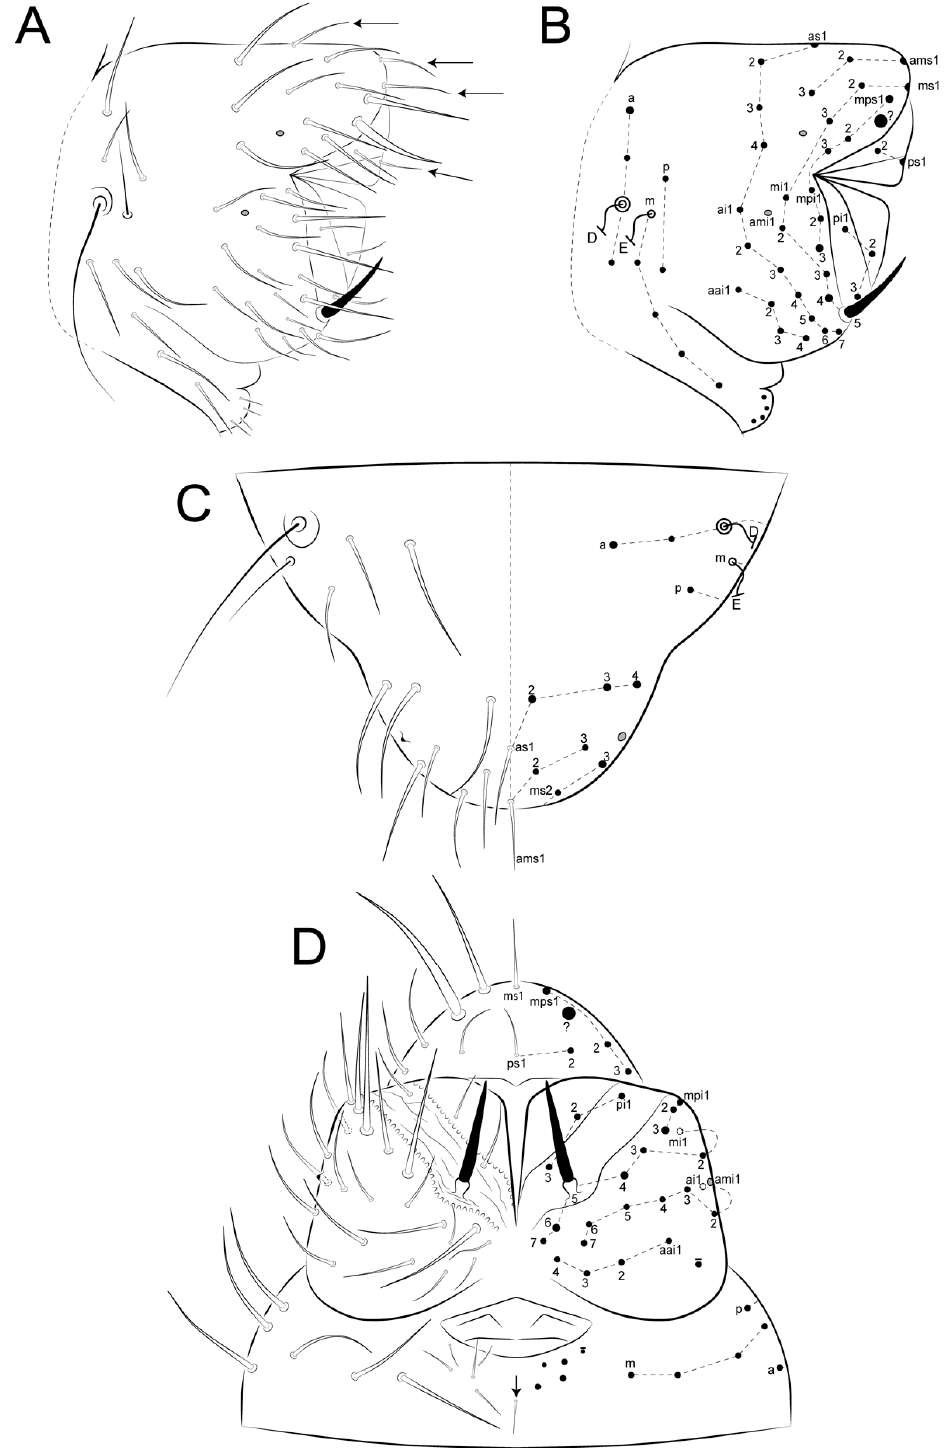
Figure 13. Arlesminthurus caatinguensis sp. nov. female small abdomen: ( A , B ) lateral view; ( A ) as observed, arrows indicate unpaired chaetae ( as1, ams1, ms1 and ps1 ), ( B ) schematic representation; ( C ) dorsal view; ( D ) ventral view of small abdomen and the genital plate; in both C and D the left side is shown as observed and the right side is a schematic representation.